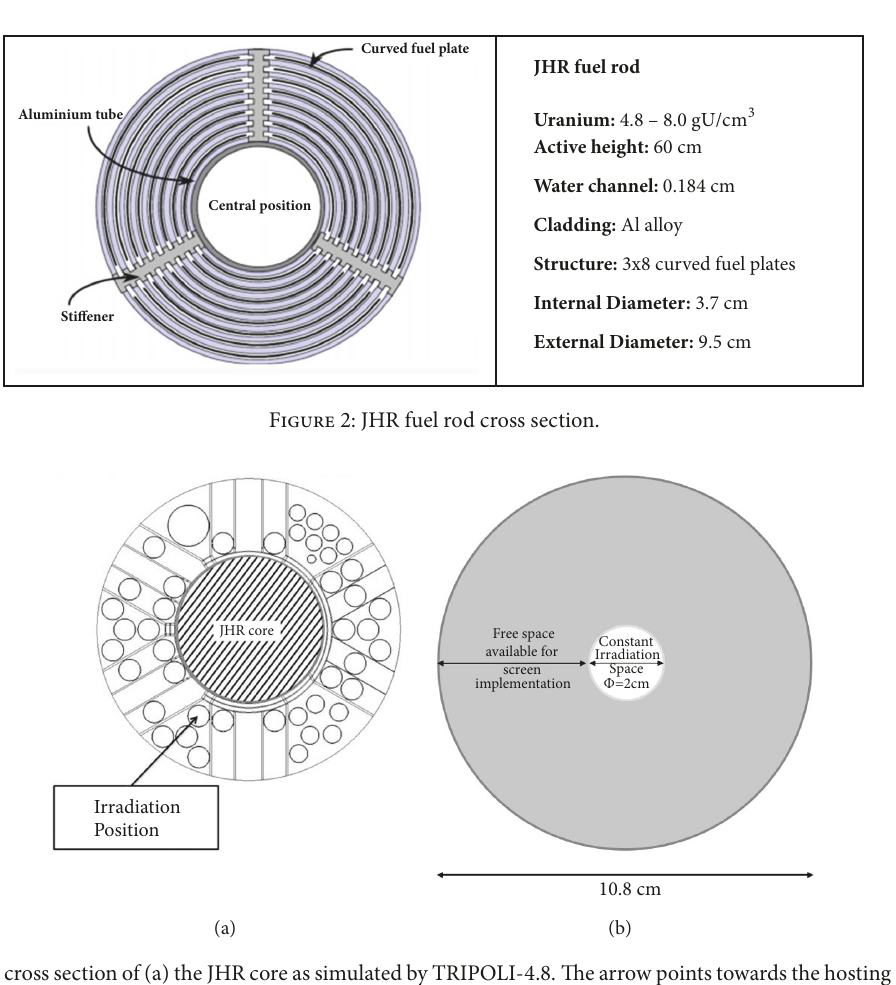
Figure 1: JHR cross section at the core middle plane. Cylindrical fuel assemblies (black) are located in an aluminum rack surrounded by an aluminum vessel (both purple); the Beryllium reflector (grey) allows locating many devices; some Zircaloy screens (orange) are also visible.